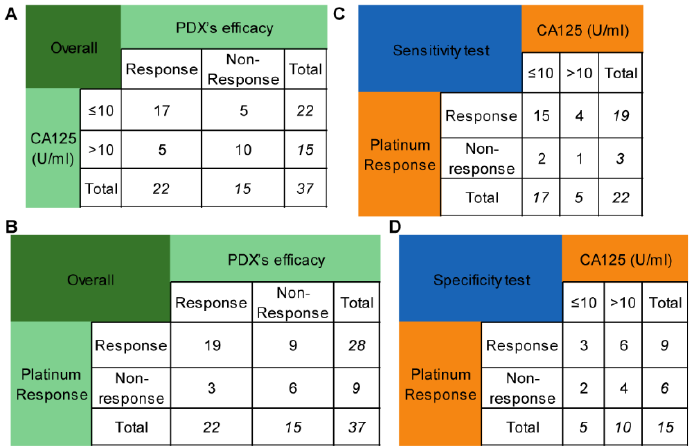
Figure 3. Comparison of the CA125 level and platinum response in predicting niraparib efficacy. ( A ) The performance of the CA125 level (truncated at 10 U/mL) in predicting niraparib efficacy. ( B ) The performance of the platinum response in predicting niraparib efficacy. ( C ) Comparison of the sensitivity of the CA125 level and platinum response to predict niraparib efficacy. ( D ) Comparison of the specificity of the CA125 level and platinum response to predict niraparib efficacy.